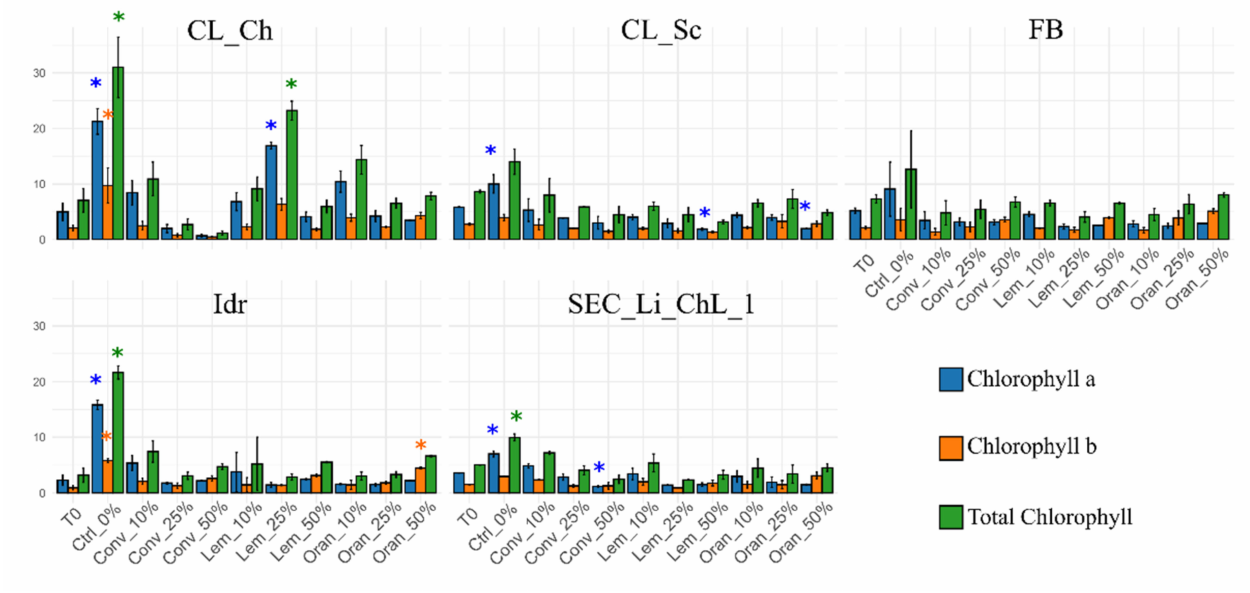
Figure 1. Pigment contents of the first screening experiment; asterisks indicate statistically significant differences between tests and the pigment content of T0 (the microalgal culture at the beginning of the experiment). “Conv” samples: vegetation water obtained with traditional method; “Lem” samples: vegetation water obtained with lemon peels extraction; “Oran” samples: vegetation water obtained with orange peels extraction. Ctrl_0% samples: only TAP